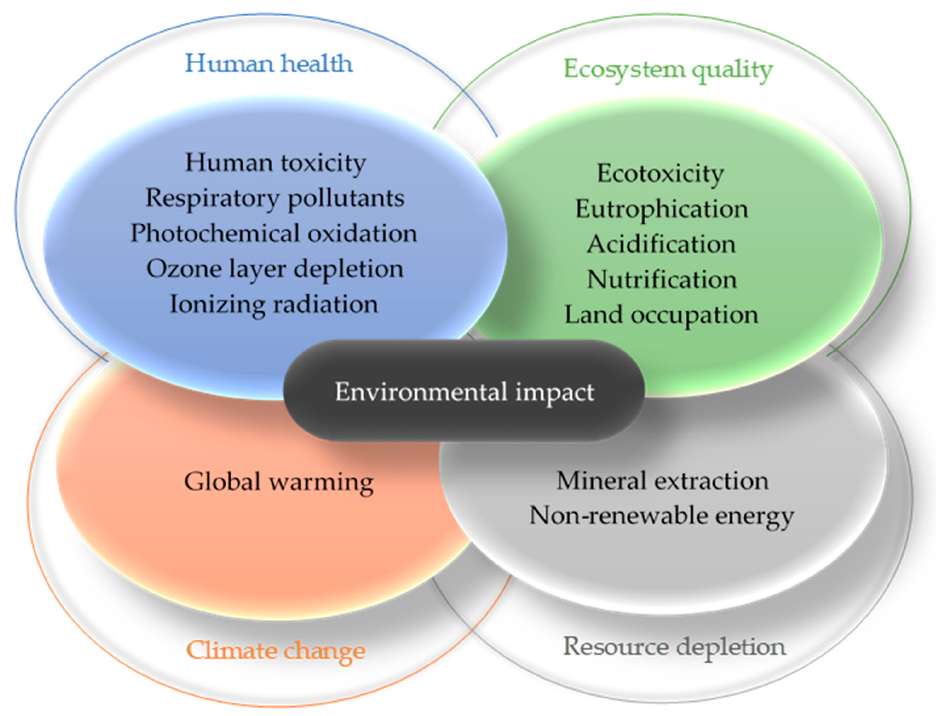
Figure 2. Example of possible environmental impacts and their relation to midpoint and endpoint impact